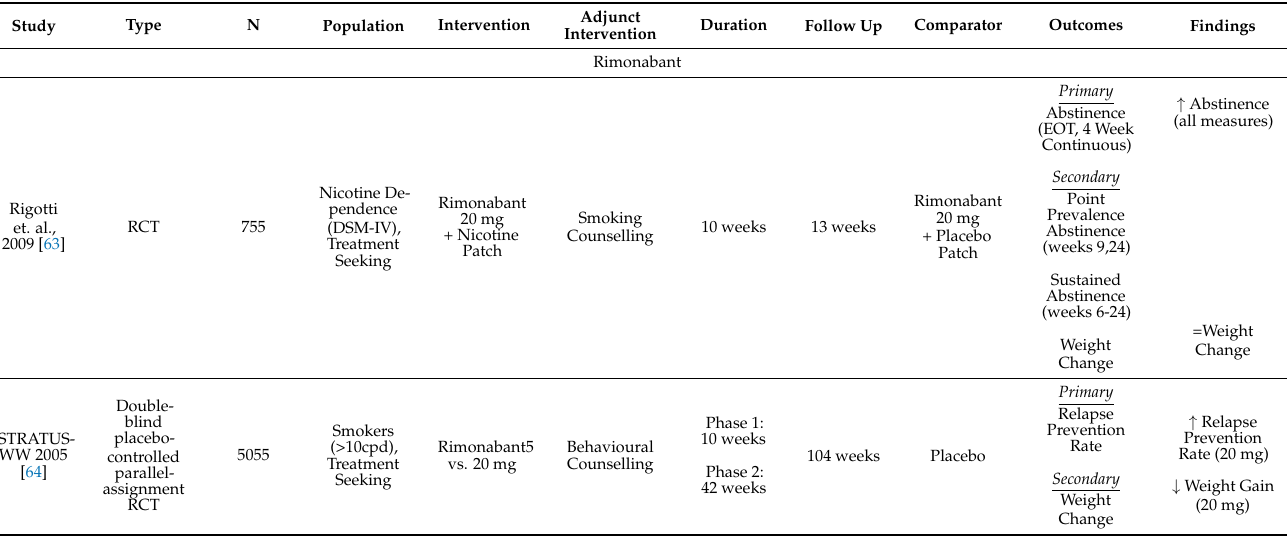
Table 7. Primary Studies pertaining to Nicotine Use